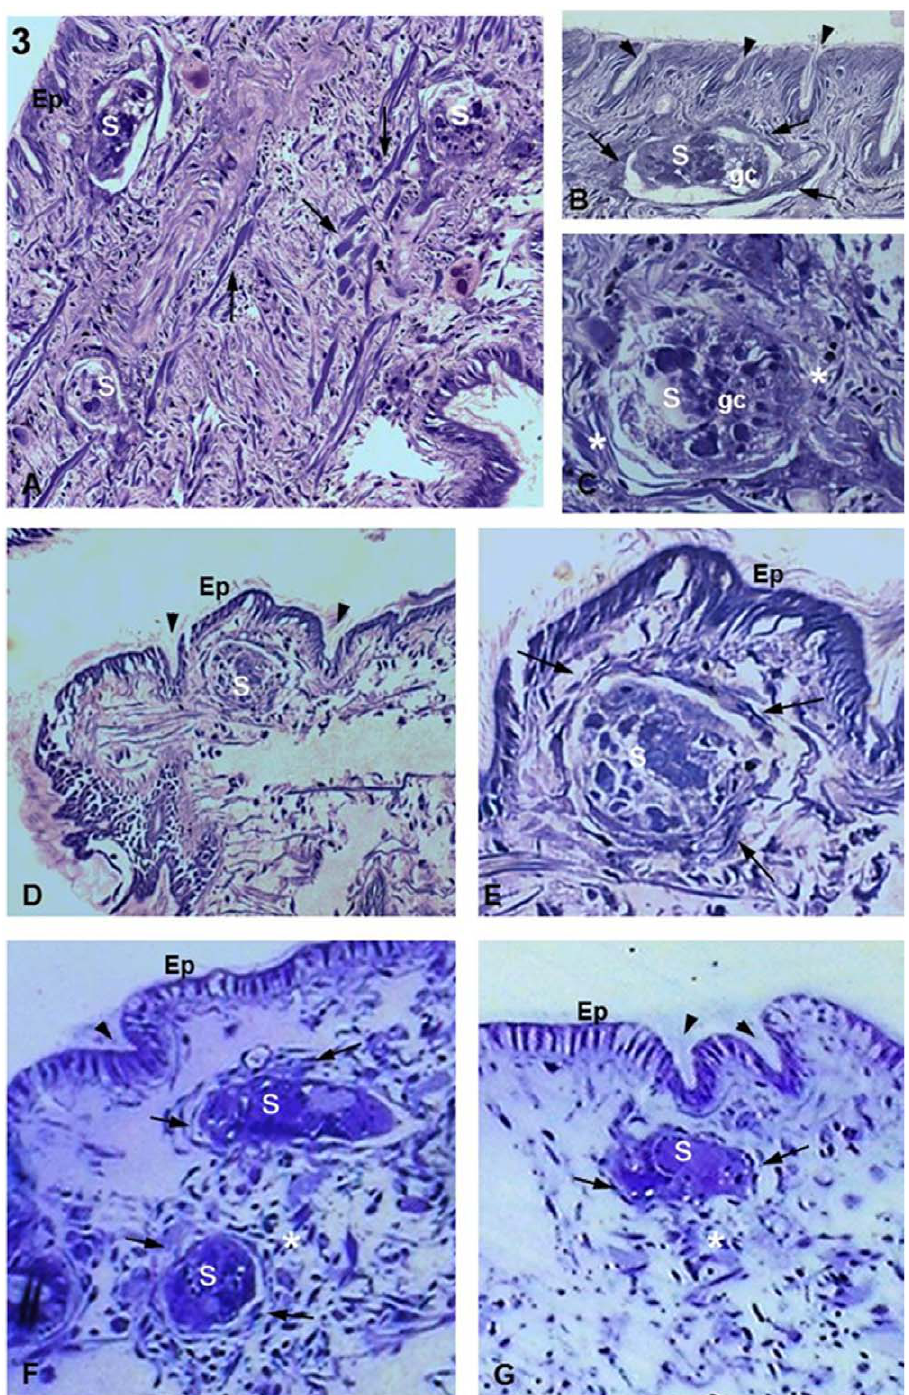
Figure 3. Biomphalariatenagophila Cabo Frio strain infected with S.mansoni. ( A ) 1 h after infection. Three sporocysts (S) are seen sectioned in distinct planes, with one appearing close to the epithelial surface (asterisk). There is an absence of a tissue response or cellular infiltration. Arrows indicate muscle fibers. Magnification 20X. ( B,C ) 1 h after infection. Details of an S inside the snail tissue showing the germinal cells characteristic of the sporocyst (germ cells; gc). In (B), there is a thin layer of fibrous cells already surrounding the parasite (arrows). By contrast, (C) shows fibrous cells (asterisks) that are not forming a layer around the parasite. Arrowheads indicate crypts. Magnifications 60X. ( D ) 5 h after infection. Low magnification showing an S located below the tegument of the snail and between two crypts (arrowheads). There is no visible damage on the epithelial surface (Ep). Magnification 20X. ( E ) 5 h after infection. Details of an S near to the Ep showing a small concentration of fibrous cells (arrows) around the sporocyst forming a thin layer. Magnification 63X. ( F,G ) 10 h after infection showing two and one S, respectively, close to the Ep with no damage or signs of parasite invasion. The images also show parasites close to the epithelial crypts (arrowheads) and an unattached concentration of fibrous cells (arrows) forming thin layers around the parasites. There is a large concentration of fibrous cells in (F) comparing to (G) (asterisks). Magnification 63X.